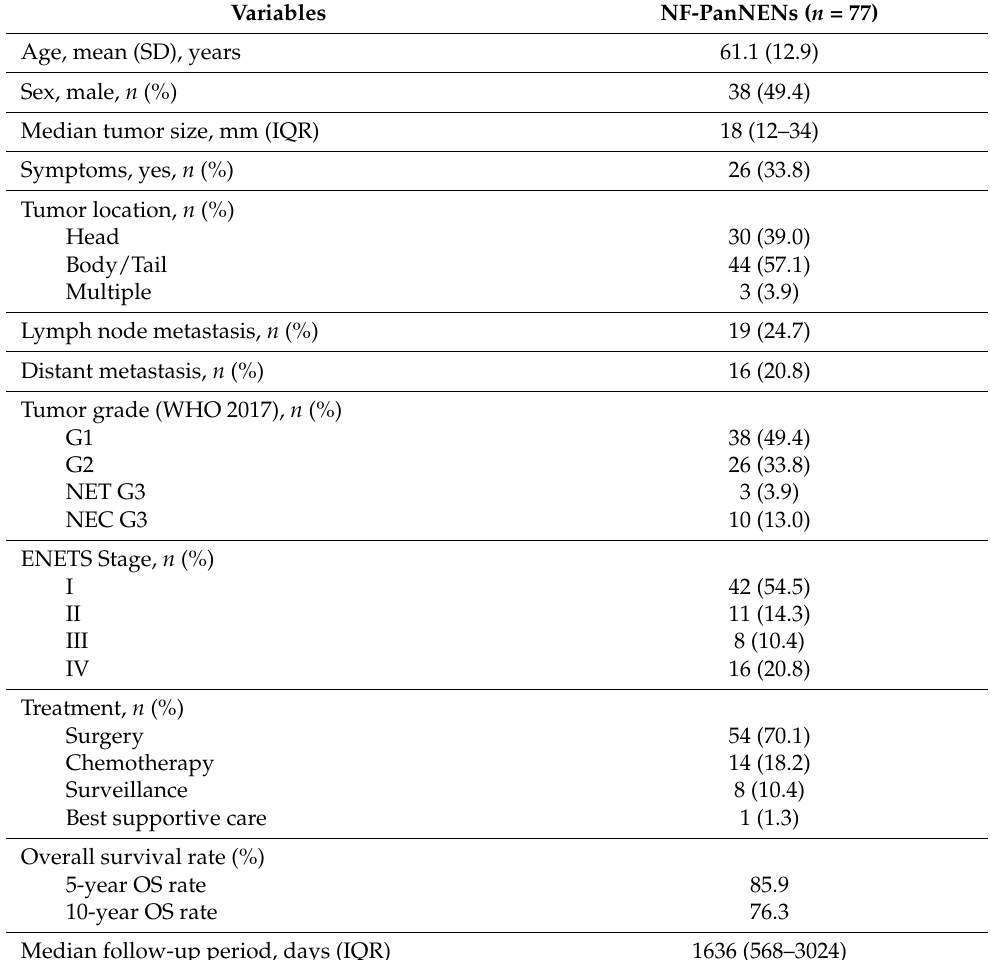
Table 1. Clinicopathological characteristics of patients with